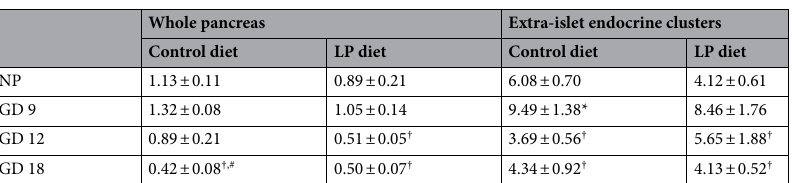
Whole pancreas Extra-islet endocrine clusters LP